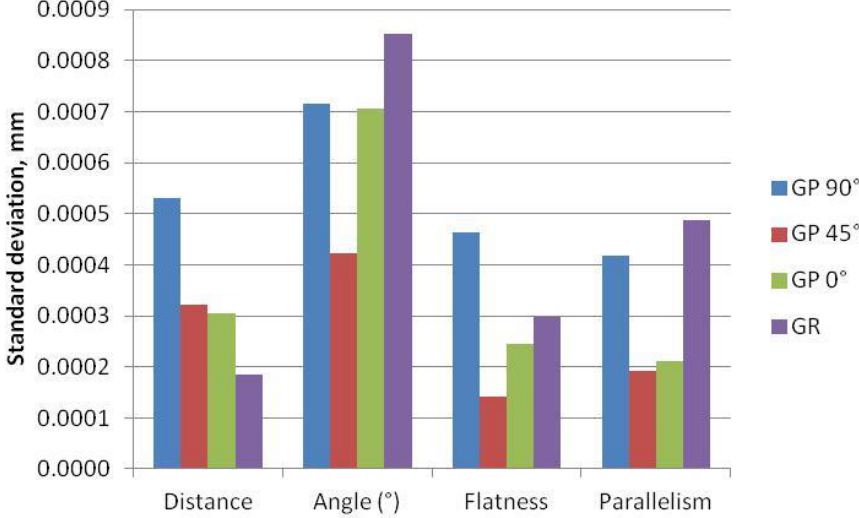
Figure 5. The standard deviations for the four chosen tasks, measured on the gauge block using different path control algorithms.